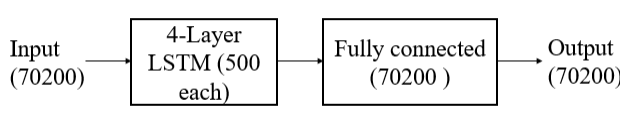
Figure 3. The neural network architecture: 4-Layer LSTM with fully connected layer.